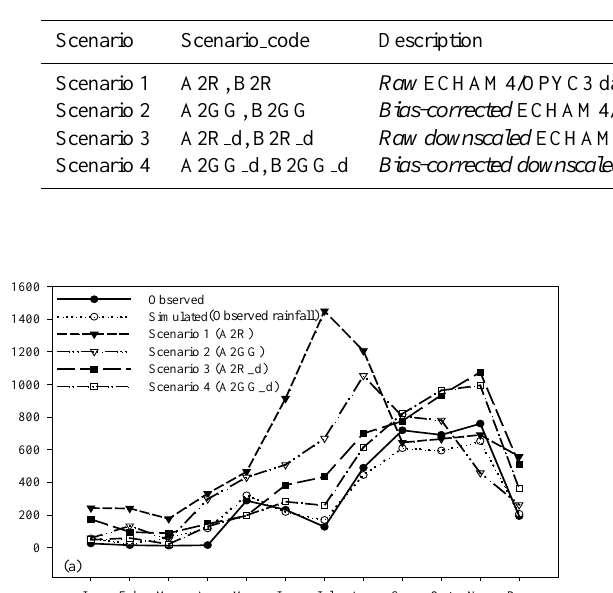
Table 5. Description of processed precipitation scenarios.